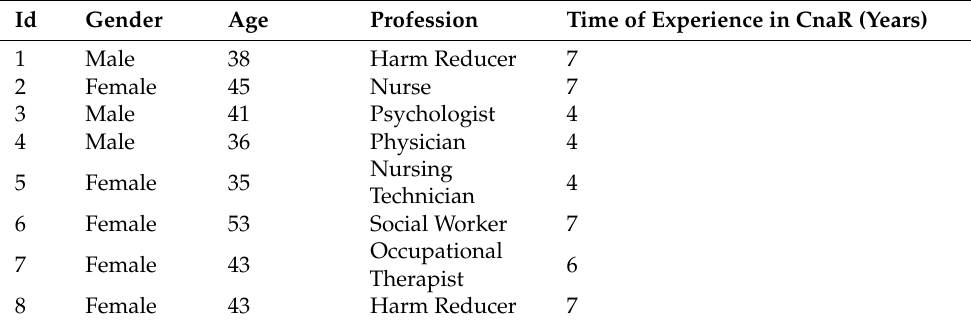
Table 1. Participant characteristics. Brazil,